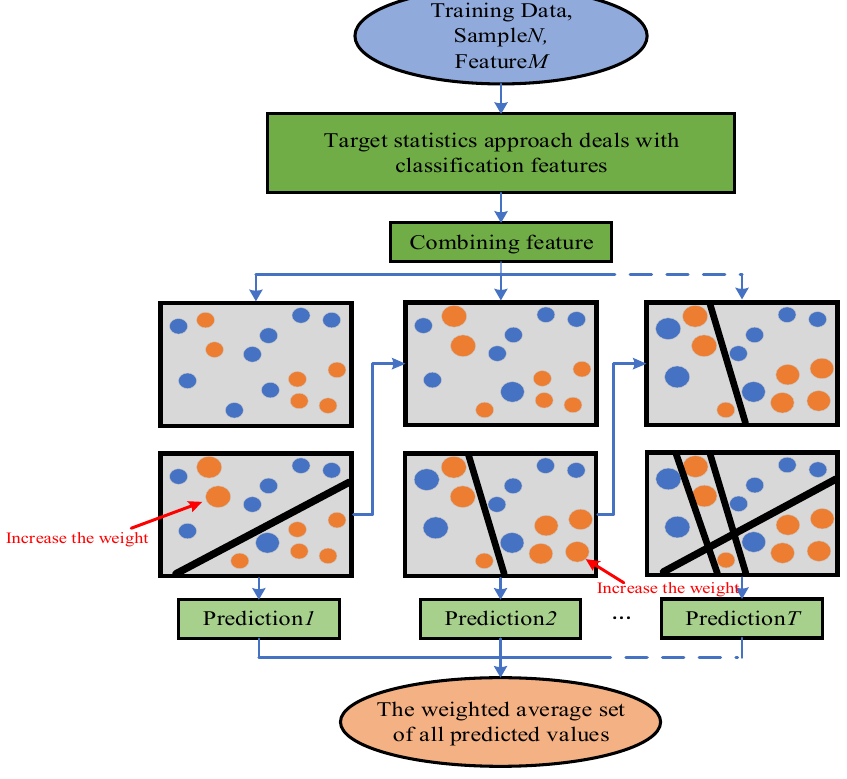
Figure 3. Flow chart of CatBoost